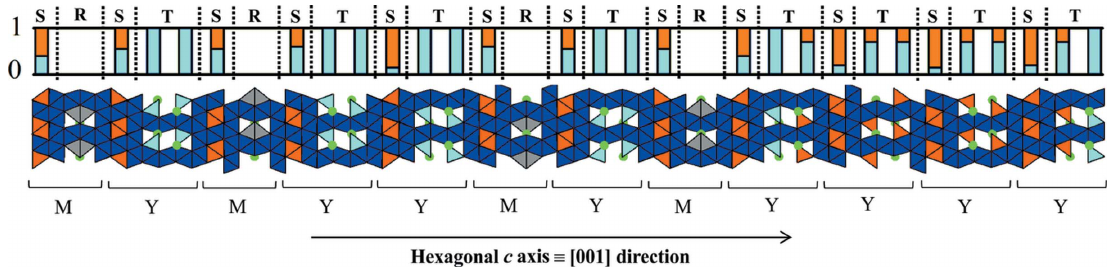
Figure 7 Partial projection of the (68) 3 hexaferrite structural model corresponding to a single MYMY 2 MYMY 4 sequence. The unit cell contains a threefold repeat of the sequence shown, with subsequent repeats translated in plane by (2/3, 1/3). The tetrahedral (light blue), octahedral (dark blue) and bipyramidal (grey) iron environments are represented. Tetrahedral mixed iron/zinc sites are shown in orange and barium atoms are shown in green. The histogram indicates the proportions of iron (light blue) and zinc (orange) occupancy in the tetrahedral